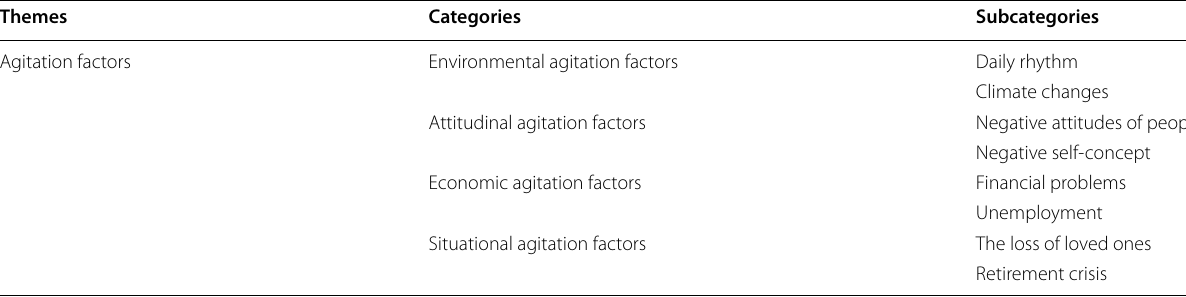
Table 3 Categories and themes extracted from in-depth interviews